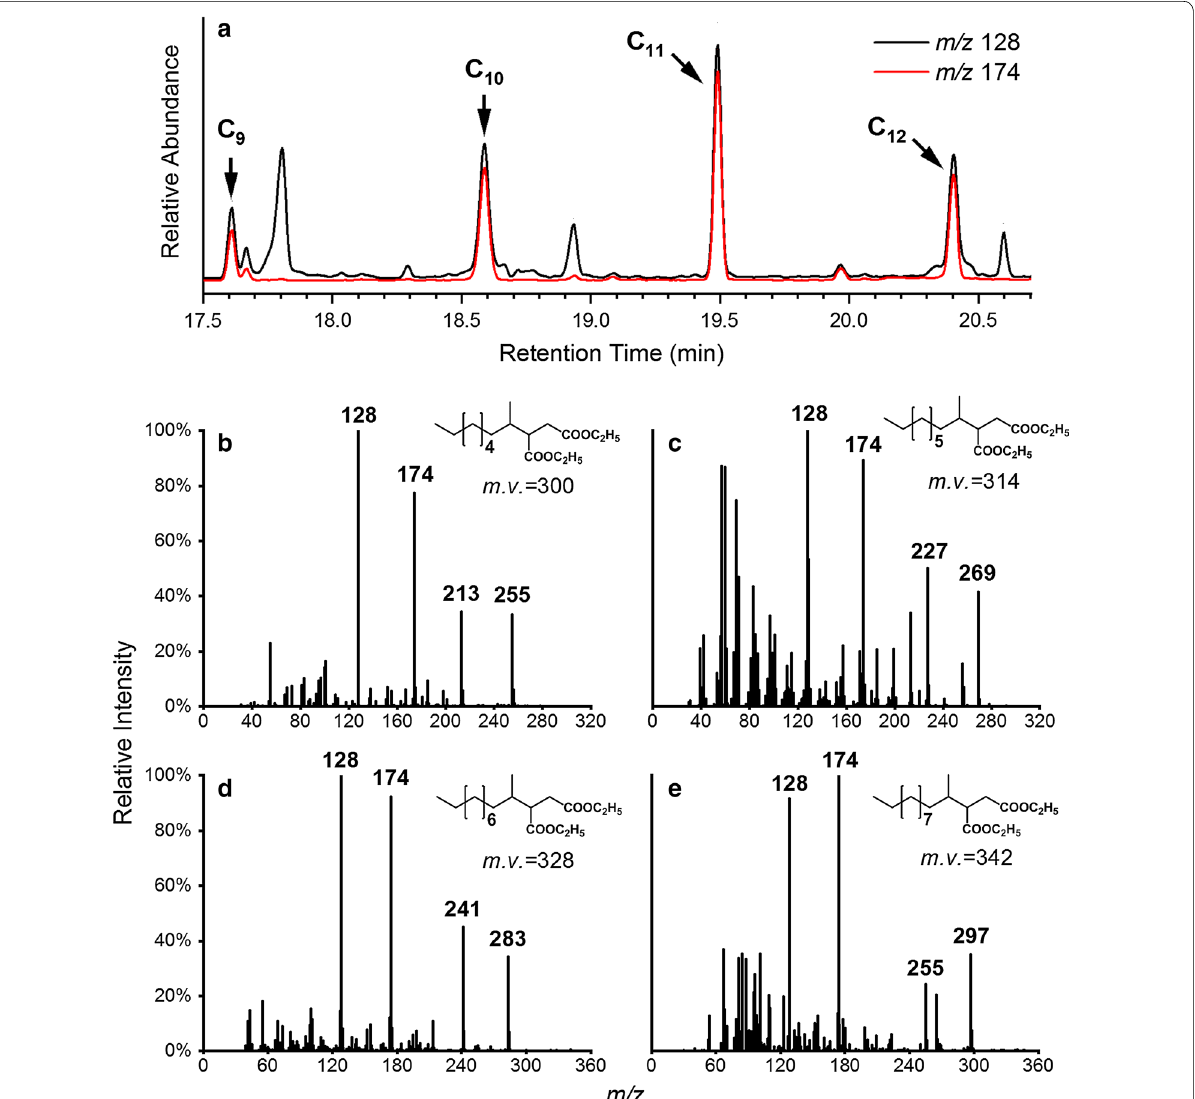
Fig. 2 Detection of putative alkylsuccinates in the alkane‑amended enrichment cultures. a Partial GC–MS m/z 128 and m/z 174 selected ion chromatogram showing the presence of (1‑methyloctyl)succinate